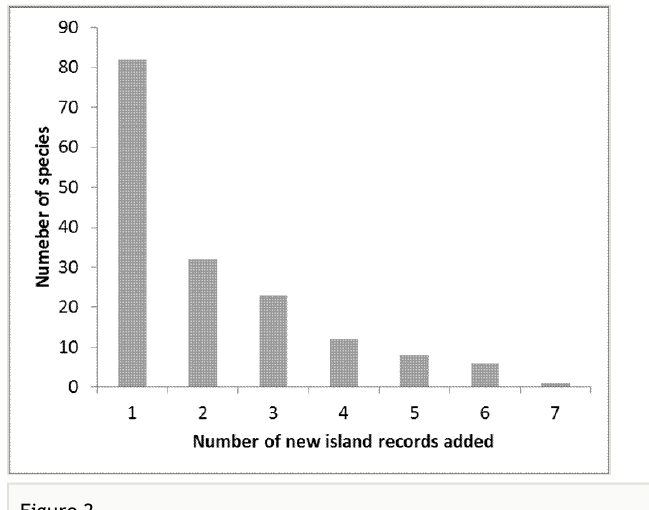
Frequency distribution of the number of new island records per species.